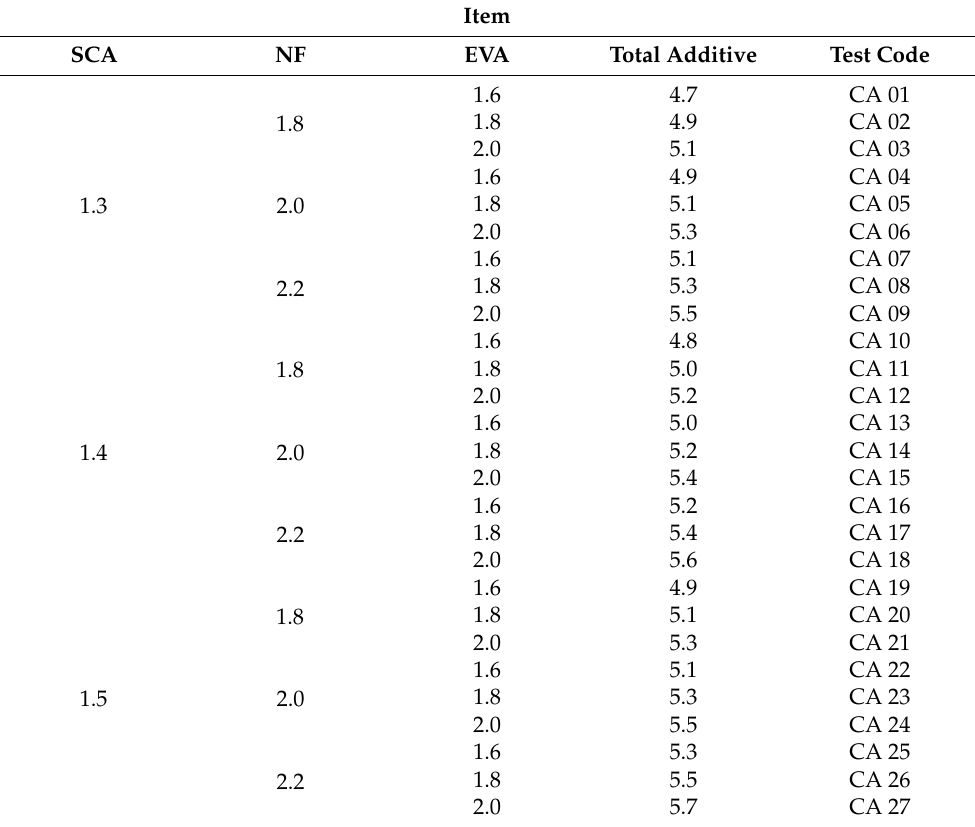
Table 11. Composite additive mixing